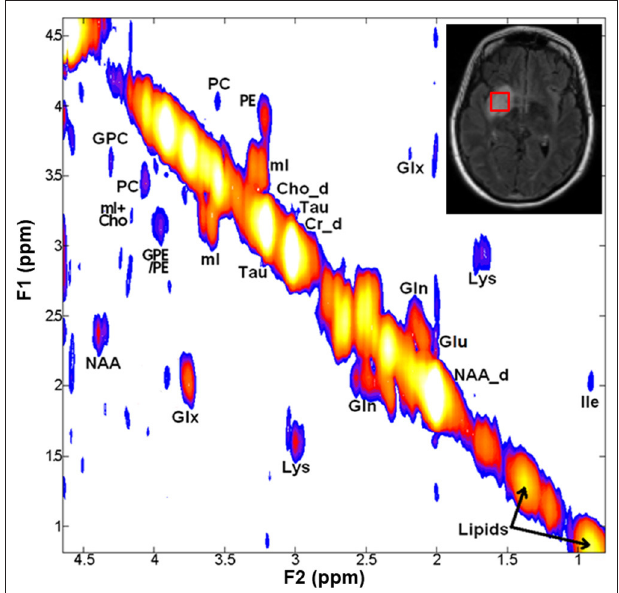
FIGURE 5 | A 2D-COSY spectrum (from a voxel placed on hyperintense signal abnormality as visible on T2-FLAIR image, right inset) from a patient with grade-III astrocytoma harboring IDH wild-type genotype showing various metabolites. Abbreviations: choline (Cho); ethanolamine (Eth); glutamate (Glu); glutamine (Gln); glutamate + glutamine (Glx); glycerophosphocholine (GPC); isoleucine (Ile); lysine (Lys); Myo-inositol (mI); N-acetyl aspartate (NAA); phosphocholine (PC); phosphoethanolamine (PE); and taurine